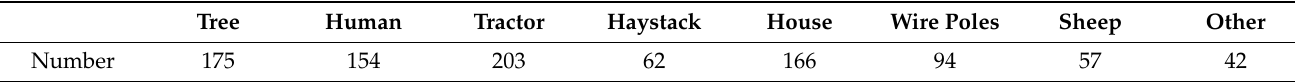
Table 3. Target categories and quantities.